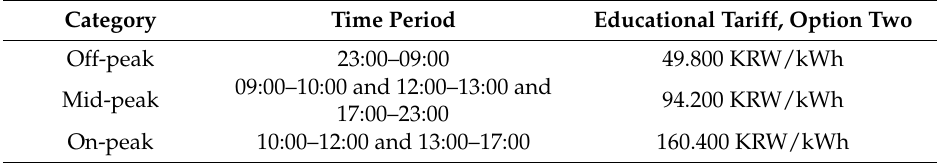
Table 6. Electricity cost of KEPCO (Korea Electric Power Corporation) during the summer season